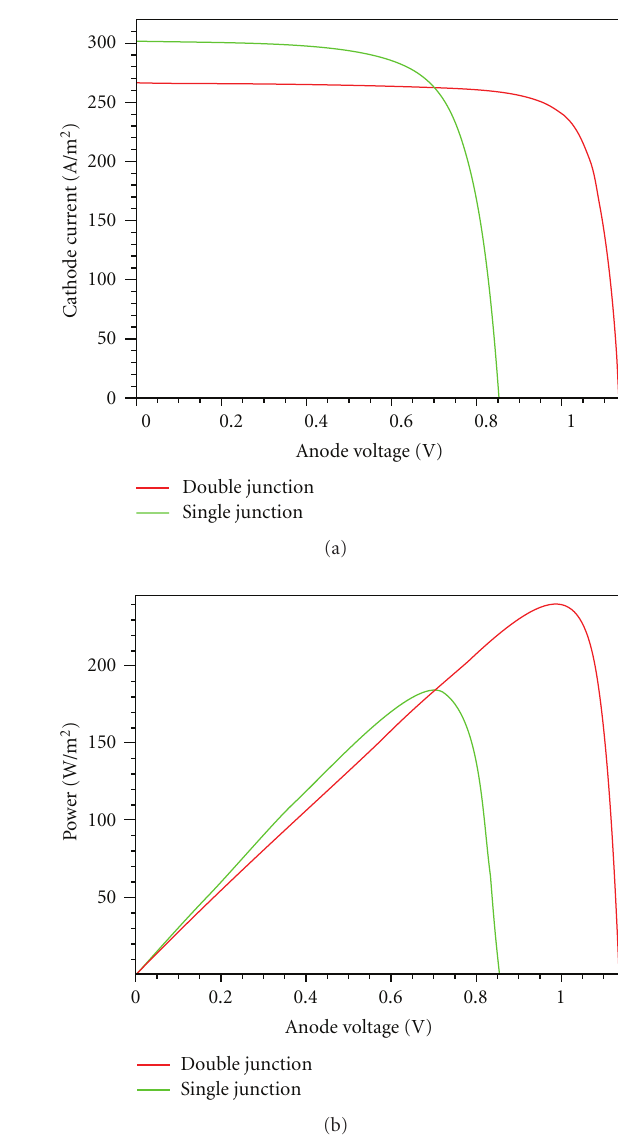
Figure 11: I-V and P-V curves of the optimized single- and double- junction solar